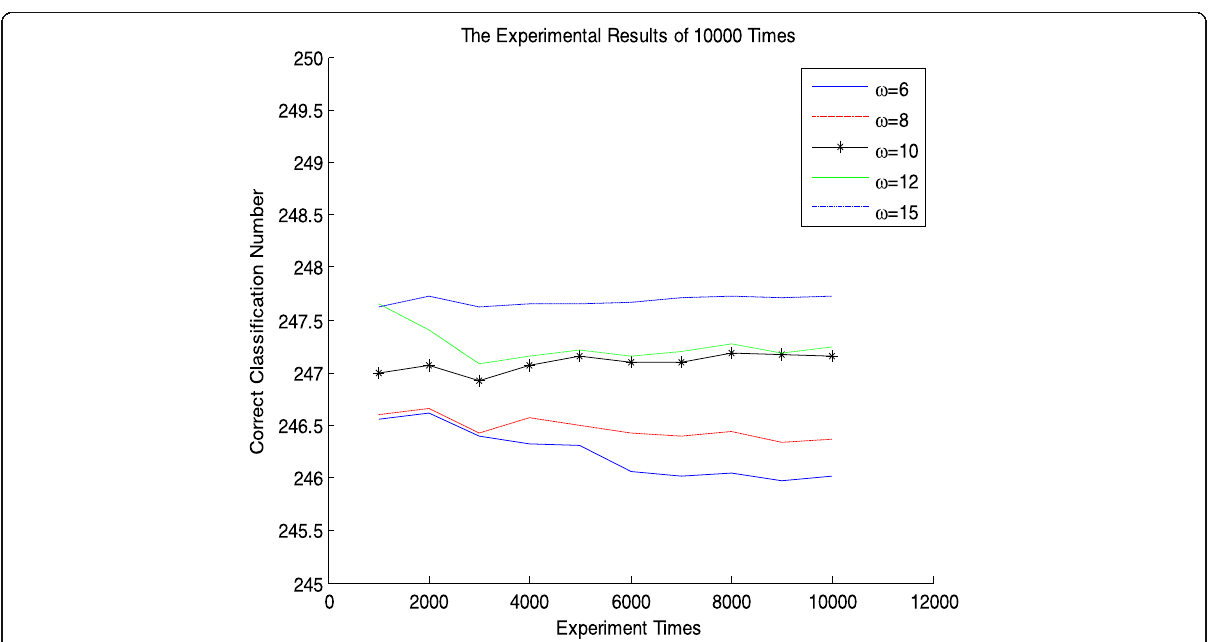
Fig. 5 Comparison of classification results of BPNN with different ω